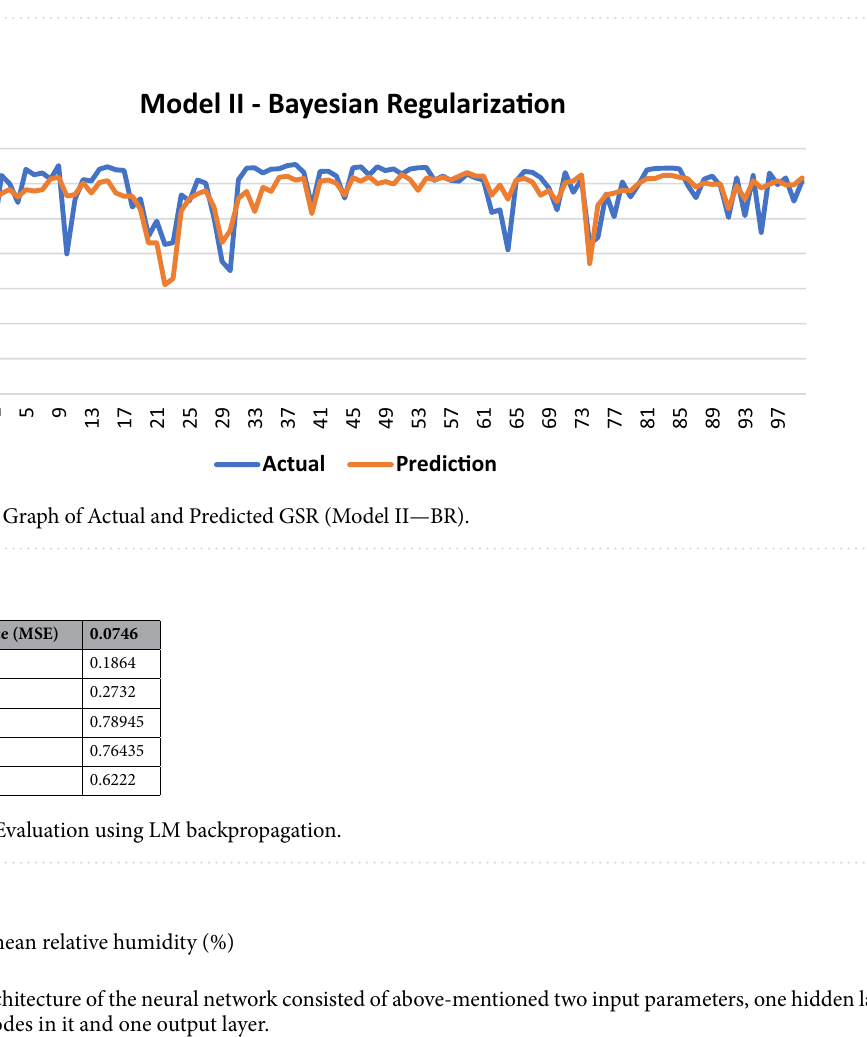
Table 7. Evaluation using BR backpropagation.